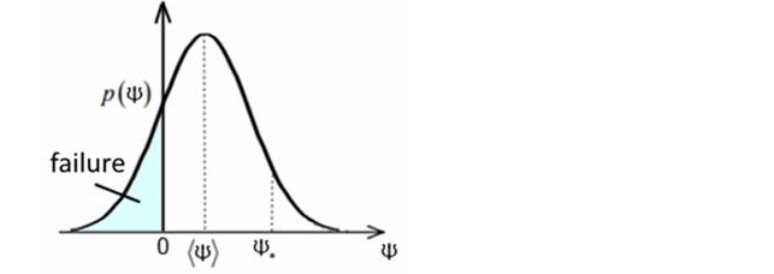
Figure 7: Example of probability density